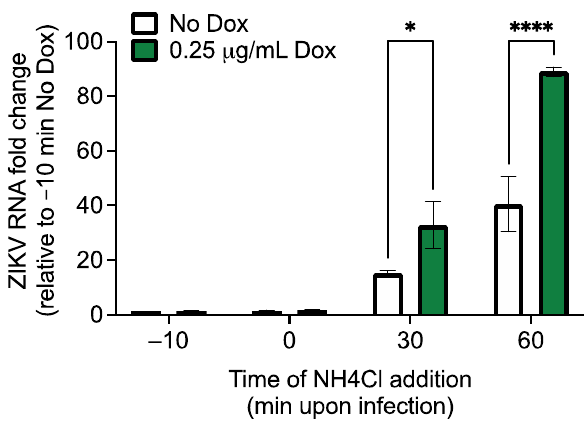
Figure 4. RhoV promotes endosomal entry of ZIKV. Inducible RhoV SNB-19 cells were treated with or without 0.25 µ g/mL Dox for 24 h prior to infection with ZIKV (MOI = 0.5 PFU/cell). NH 4 Cl was then added to cells pre-, at, or post-virus addition ( − 10, 0, 30, or 60 min). After 2 h adsorption with ZIKV, the cells were washed with PBS and Dox was added back to the media during the course of infection. ZIKV-infected cells were then lysed at 24 h.p.i. for RNA extraction and reverse transcription. ZIKV RNA levels were quantified by RT-qPCR and normalized to that of untreated cells incubated with NH 4 Cl at 10 min pre-virus addition ( − 10 min No Dox). The data are representative of two independent experiments. Asterisks indicate statistically significant differences (two-way ANOVA and Sidak’s multiple comparisons test: *, p < 0.05; ****, p < 0.0001).